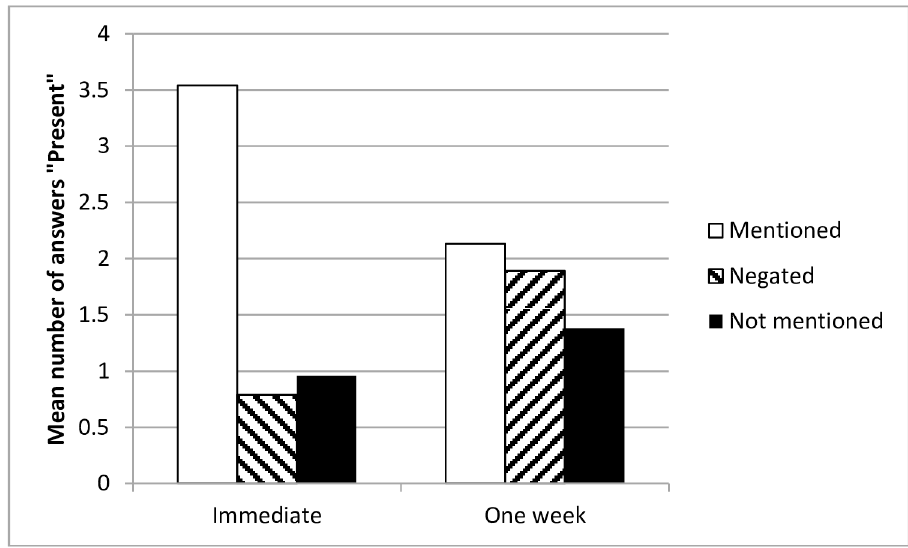
Fig 3. Mean number of ‘Present’ answers as a function of delay and type of information- Experiment 3.